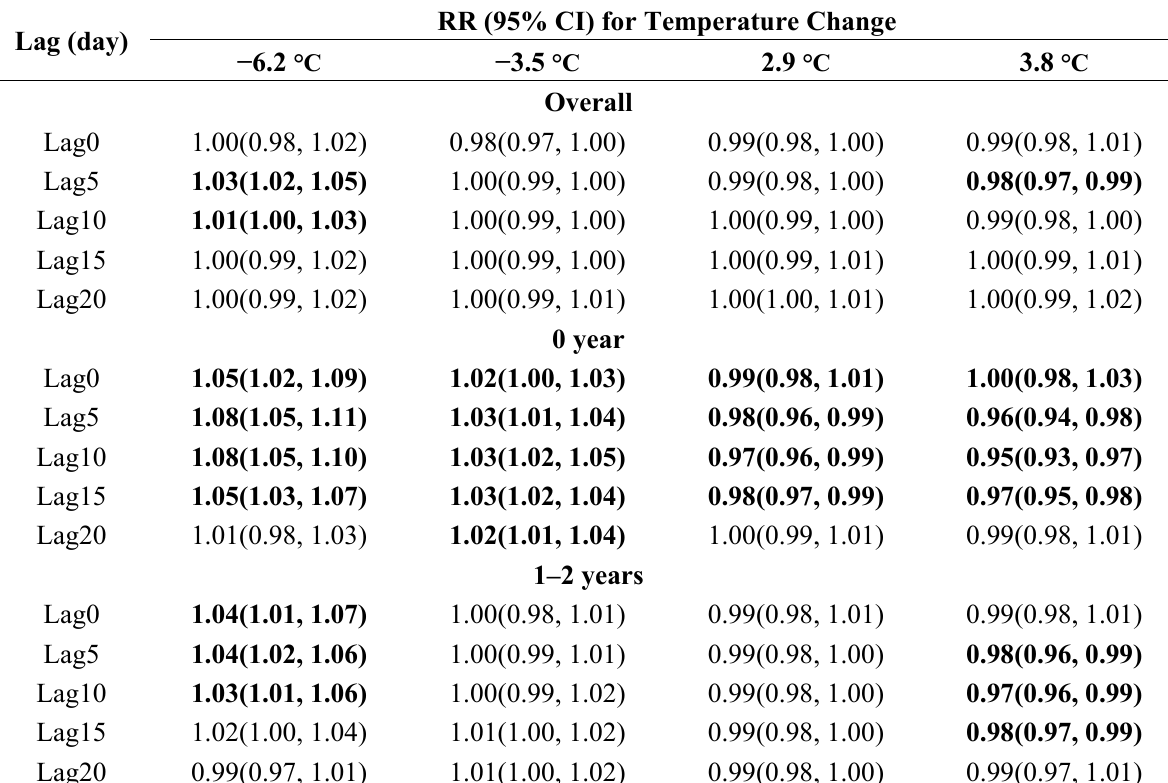
Figure 4. Relative risk of an outpatient visit for a respiratory tract infection (RTI) by temperature change (°C), days of lag, and subgroups of age. The reference value was 0 °C temperature change. Table 2. The effects of temperature change on different groups of outpatient visits for respiratory tract infections (RTIs), with 1%, 5%, 95% and 99% percentiles of temperature change relative to the reference 0 °C temperature change at different lag days in